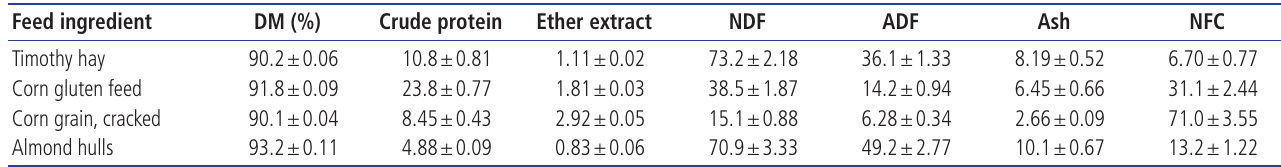
Table 2. Nutrient composition of timothy hay, corn gluten feed, corn grain, and almond hulls (values based on % of DM; mean±standard deviation) Feed ingredient DM (%) Crude protein Ether extract NDF ADF Ash NFC Timothy